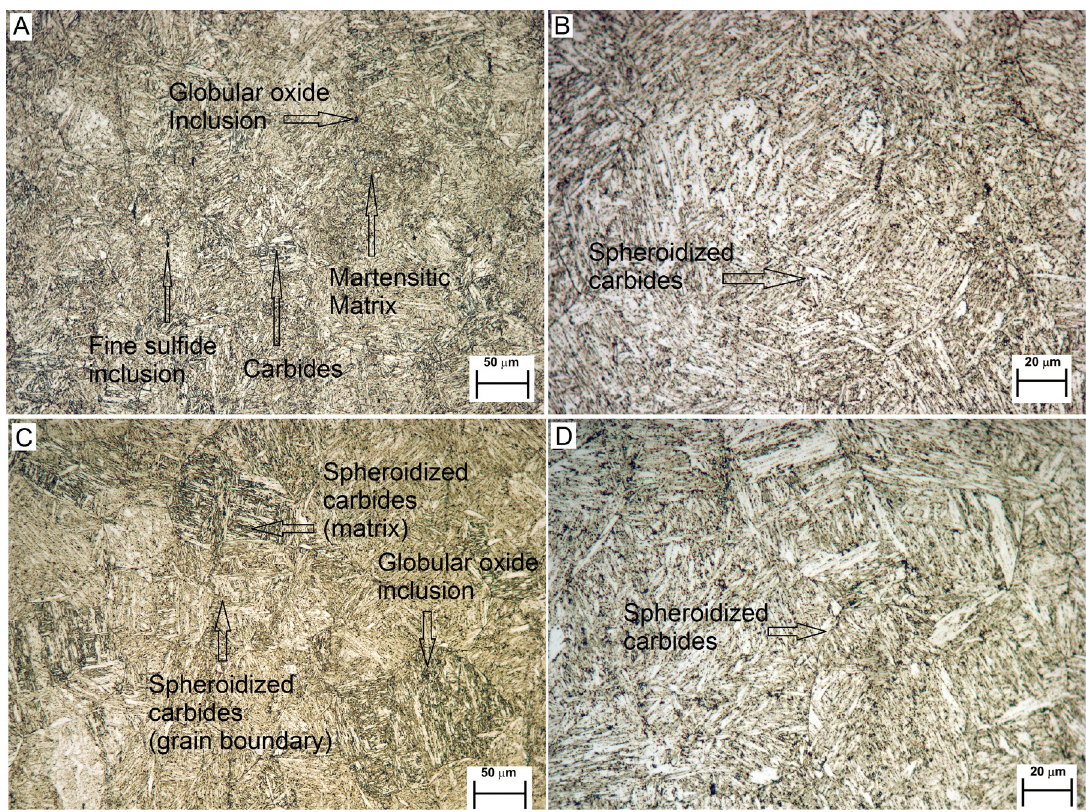
Figure 6. Optical images of etched cross-sectional surfaces of the X20CrMo13 type steel blades. (A) The region below the P2 blade’s fractured surface. (B) Detail of (A) showing spheroidized carbides precipitated in the grain boundaries. (C) Cross-sectional region at the base of the VB blade (without service). (D) Detail of (C) showing spheroidized carbides precipitated at the grain boundaries (Villela’s